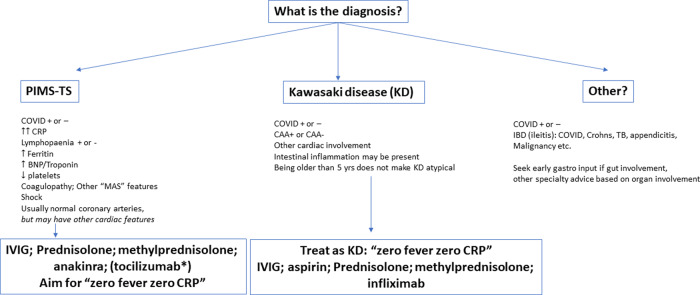
Pragmatic stratified therapeutic approach for PIMS-TS in an expert MDT settingPIMS-TS: paediatric inflammatory multi-system syndrome temporally related to SARS-CoV-2; MDT: multidisciplinary team; COVID: coronavirus disease; BNP: brain natriuretic peptide; MAS: macrophage activation syndrome; CAA: coronary artery aneurysm; TB: tuberculosis; gastro: gastroenterology. *Tocilizumab in parentheses, since not used in our series of patients, but is being explored in clinical trials of Covid-19, so may be a therapeutic option for PIMS-TS.